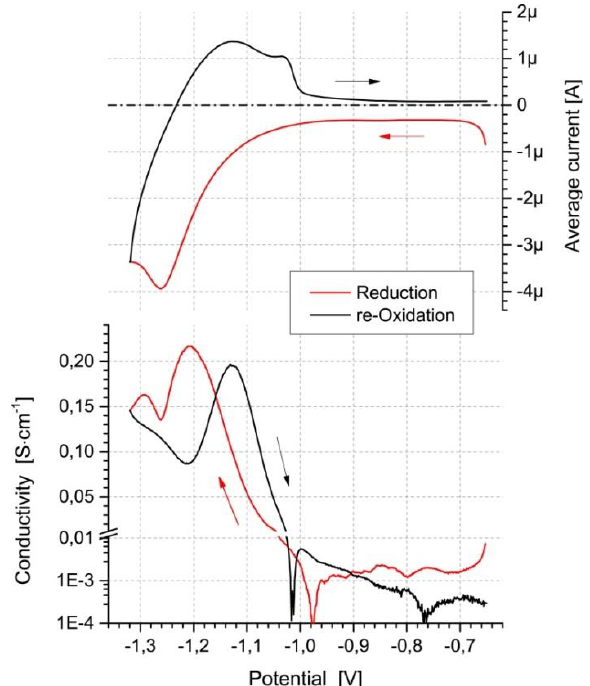
Figure 11. Time-resolved potential and compound (pseudo-CV) current and conductivity plots for PNDI-C deposited at interdigitated Pt/glass comb electrode pair. Potential scanning rate: 1 mV s −1 , working electrode offset potential: 5 mV, 0.1 M Bu 4 NPF 6 /ACN supporting electrolyte. Reprinted